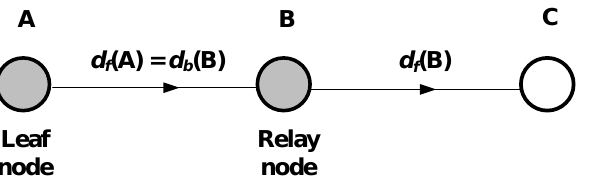
Figure 2. Scenario under analysis: node A generates and transmits a packet and node B receives and forwards this packet to its next-hop